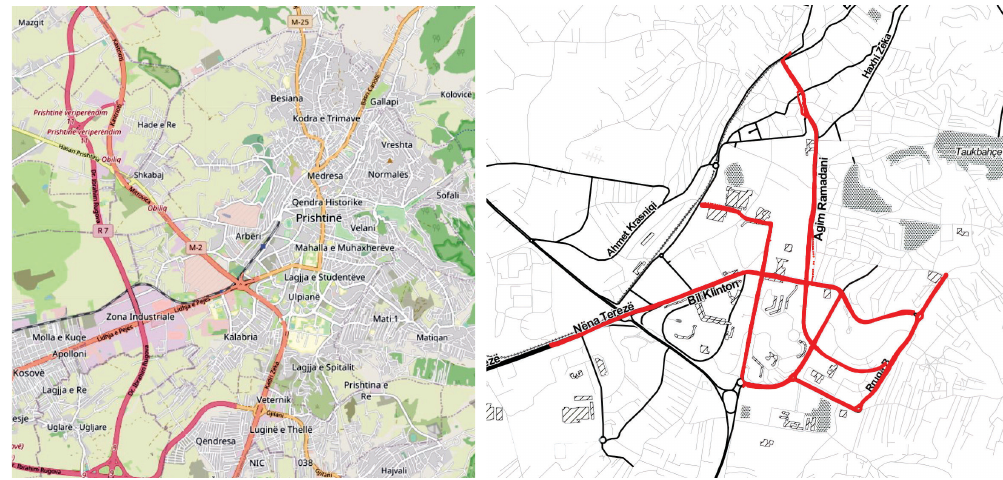
Figure 2. Urban zone of